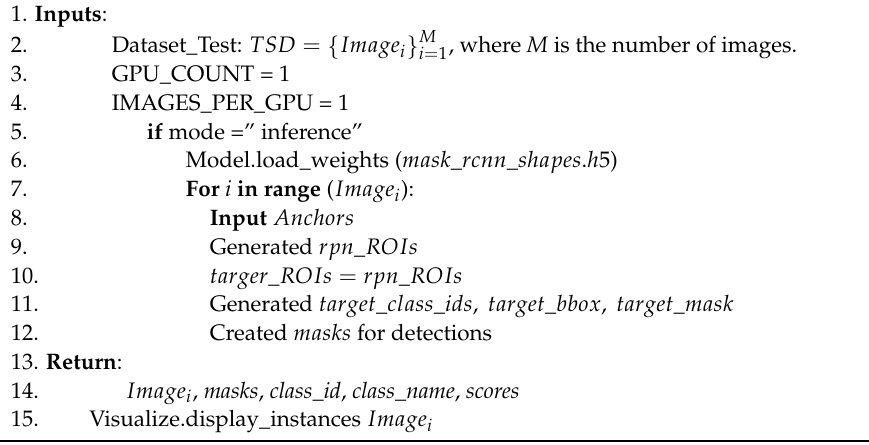
Algorithm 2. Testing Phase in Mask R-CNN